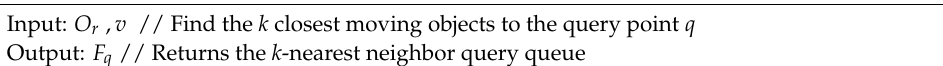
Algorithm 2. Continuous k -nearest neighbor